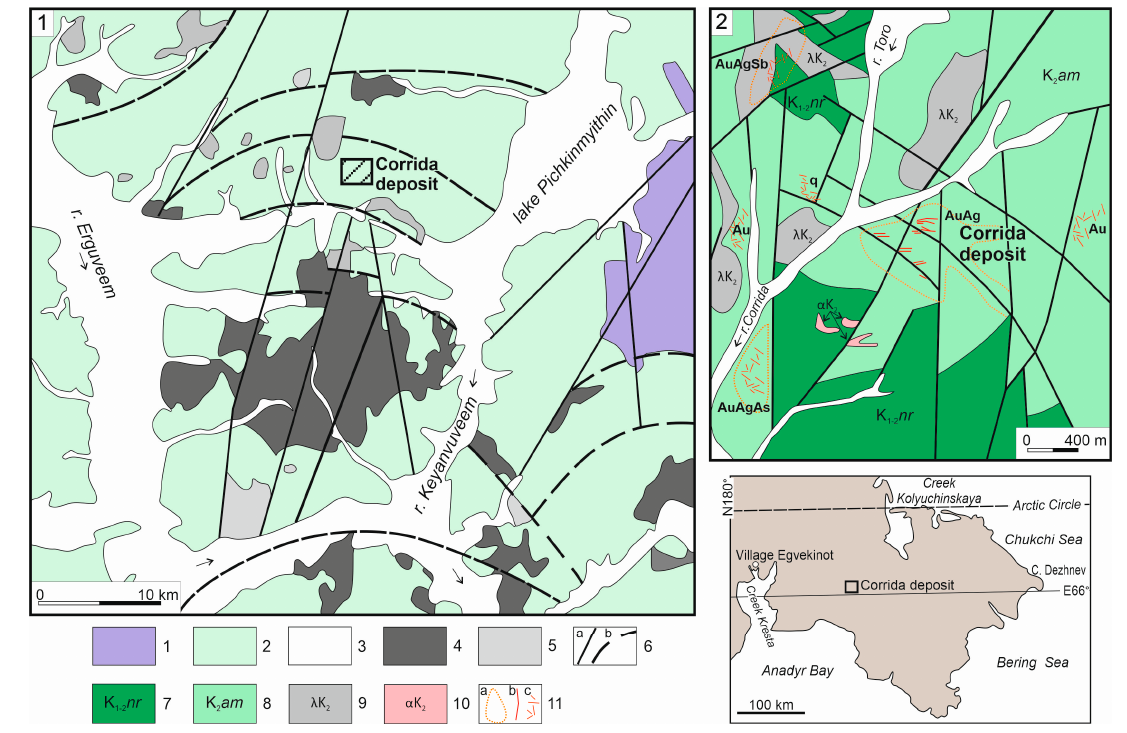
Figure 1. Geological map of the Erguveyem ore district (1) and the Corrida ore field (2) [24,26]. 1–6—illustration (1): 1—Late Triassic–Early Cretaceous volcanogenic ‐ terrigenous ‐ siliceous formation; 2—Cretaceous volcanic rocks; 3—Quater ‐ nary aqueoglacial and alluvial formations, with the main water flow directions; 4—Late Cretaceous granitoids; 5—Late Cretaceous subvolcanic rhyolite and andesite bodies; 6—tectonic dislocations: a—faults; b—dislocations of volcanic–tec ‐ tonic structures; 7–11—illustration (2): 7—volcanic rocks of the Nyrvakinot Formation; 8—volcanic rocks of the Amgen’ Formation; 9, 10—Late Cretaceous subvolcanic bodies: 9—rhyolite; 10—andesite; 11—ore features: a—hydrothermal ‐ met ‐ asomatic alteration zones; b—lodes; c—stockwork veinlet zones.